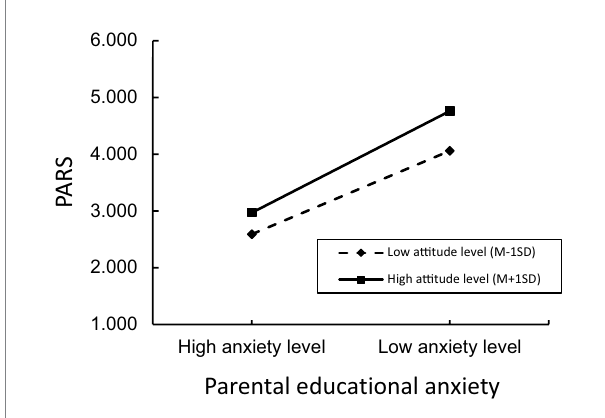
FIGURE 2 The moderating effect of parents on children’s exercise